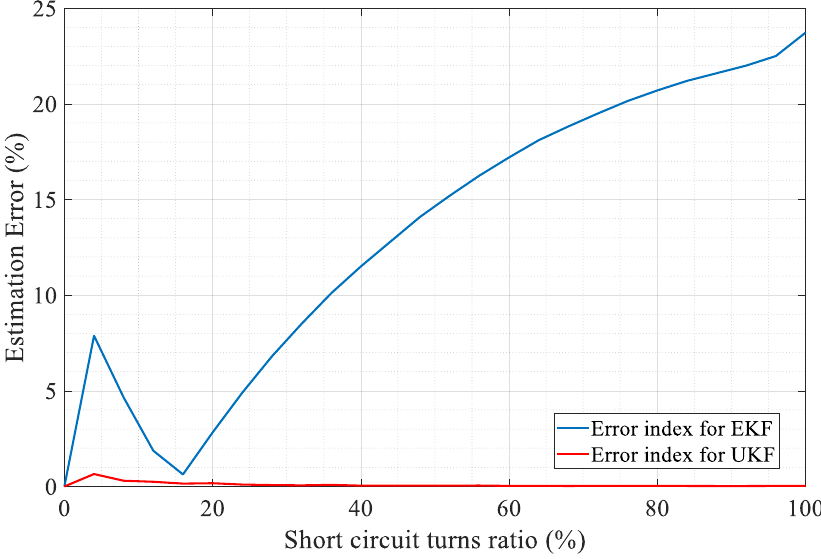
Figure 10. Error Index of the estimated parameter 𝒏 𝒔/𝒄 .